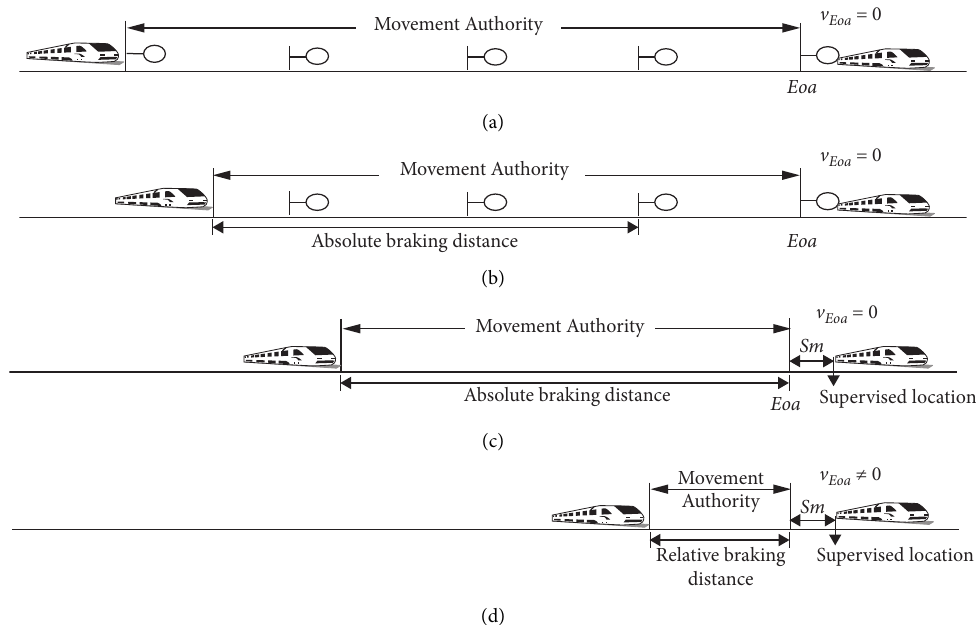
Figure 1: Typical train separation principles. (a) Fixed-block. (b) Quasimoving-block. (c) Moving-block. (d) Virtual coupling.